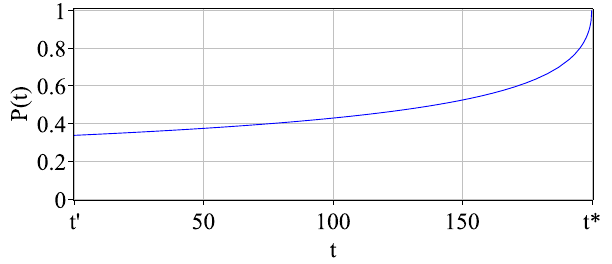
Figure 2. The plot of probability distribution P 34 ( t )